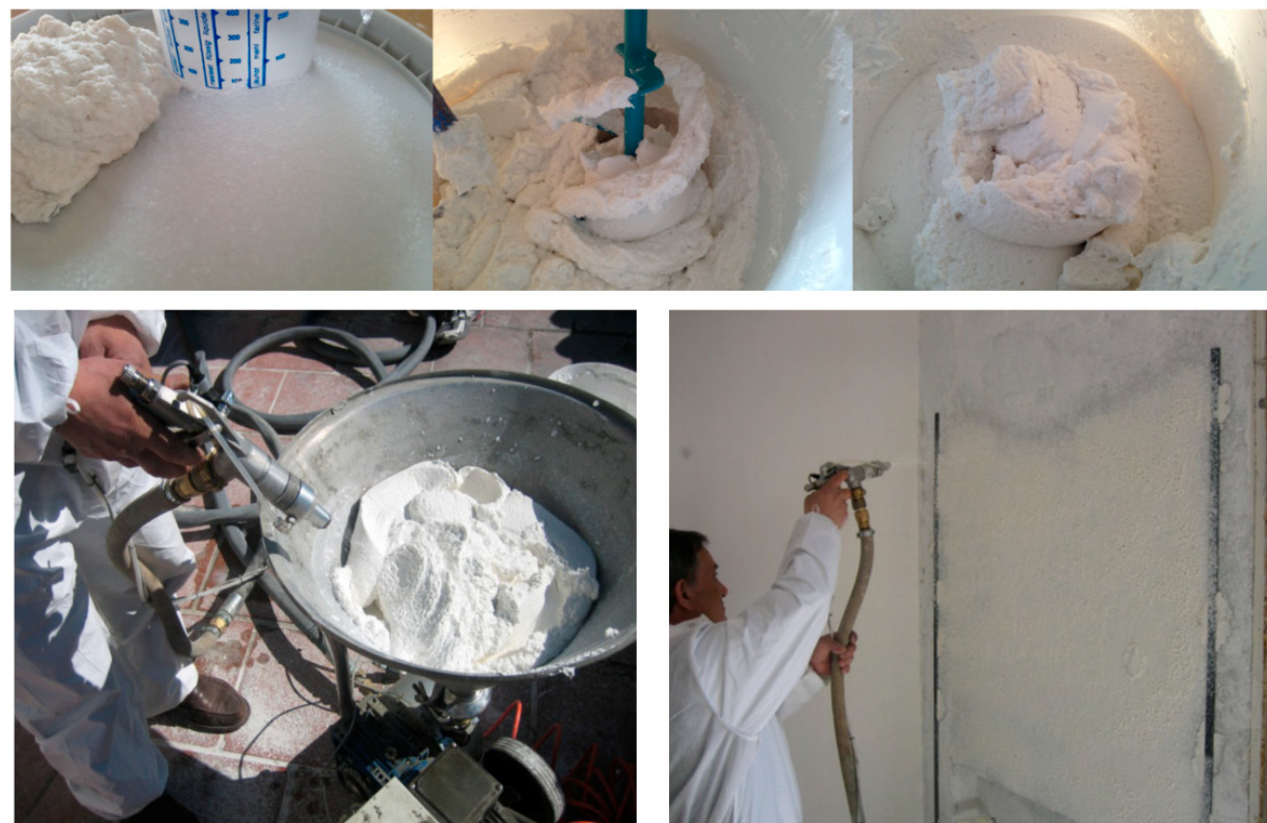
Figure 7. Aerogel-based plaster in building constructions [41].